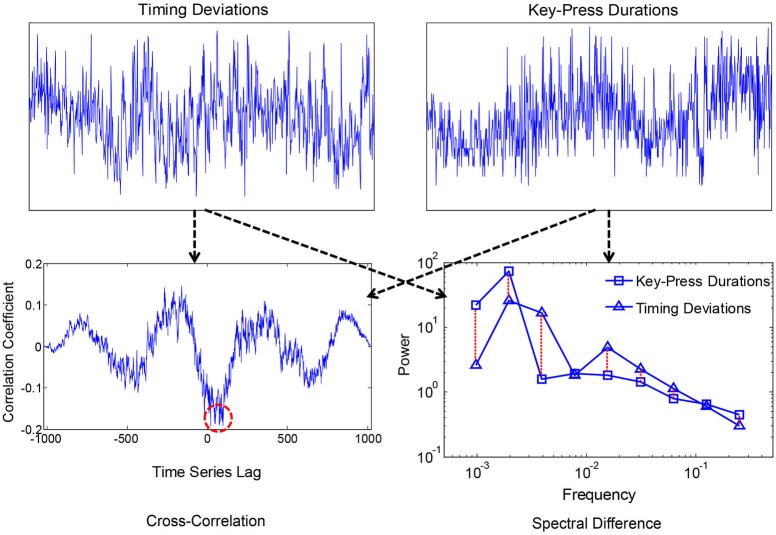
Time series of peak key-press response times and durations for one participant (above), where the x-axis was the sequence of over 1000 key-presses, and the y-axis is normalized times and durations with 0 mean and showing +/−2.5 standard deviations. Corresponding cross-correlation function and spectra are shown below. The red dashed circle shows the peak negative correlation, and the dashed lines between spectra show absolute log differences.